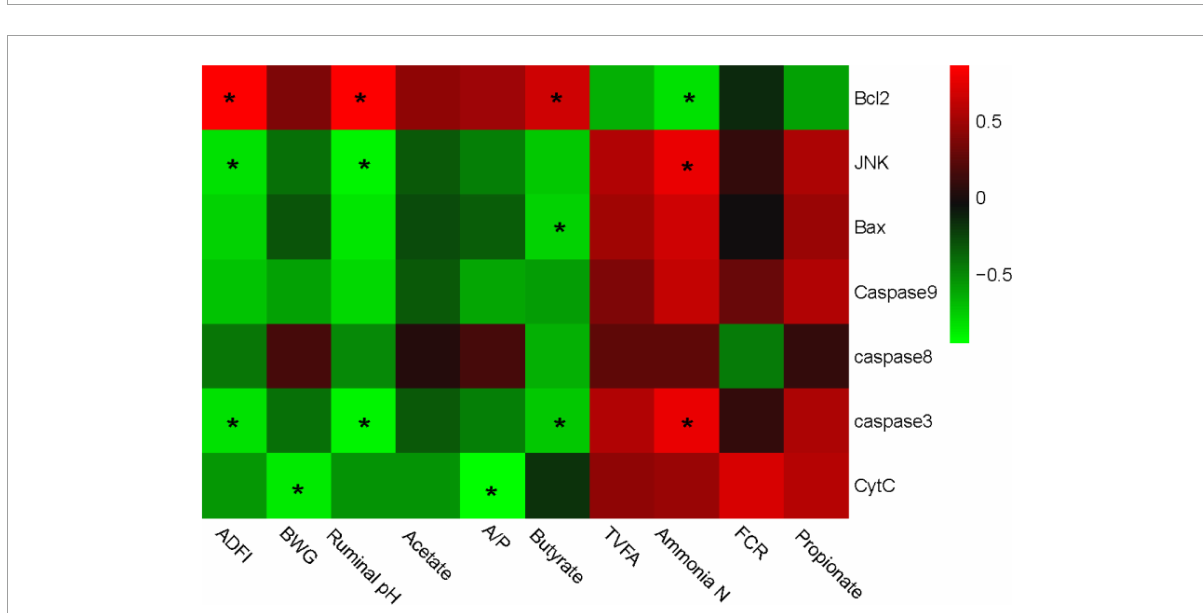
FIGURE3 Correlation analysis between production performances, rumen fermentability parameters, and epithelial apoptosis-related genes expression. The red color represents a positive correlation while the green color represents a negative correlation. “*” means a significant